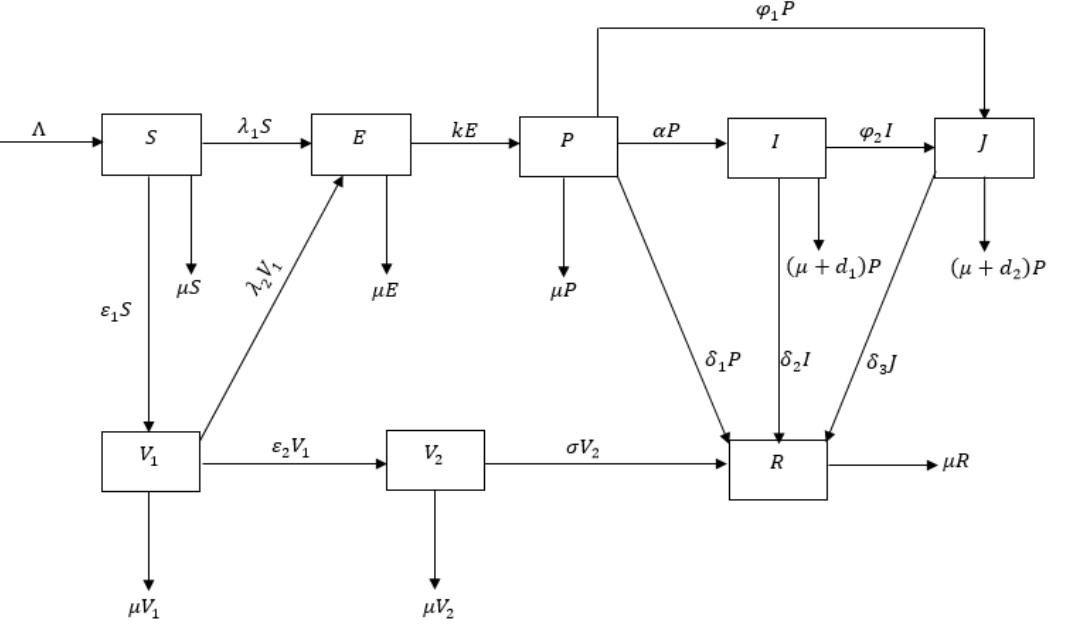
Figure 1. Model flow diagram for transmission dynamics of measles